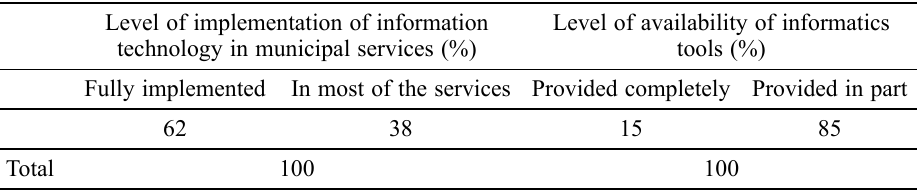
Table 2. Level of implementation of information technology and availability of informatics Level of implementation of information